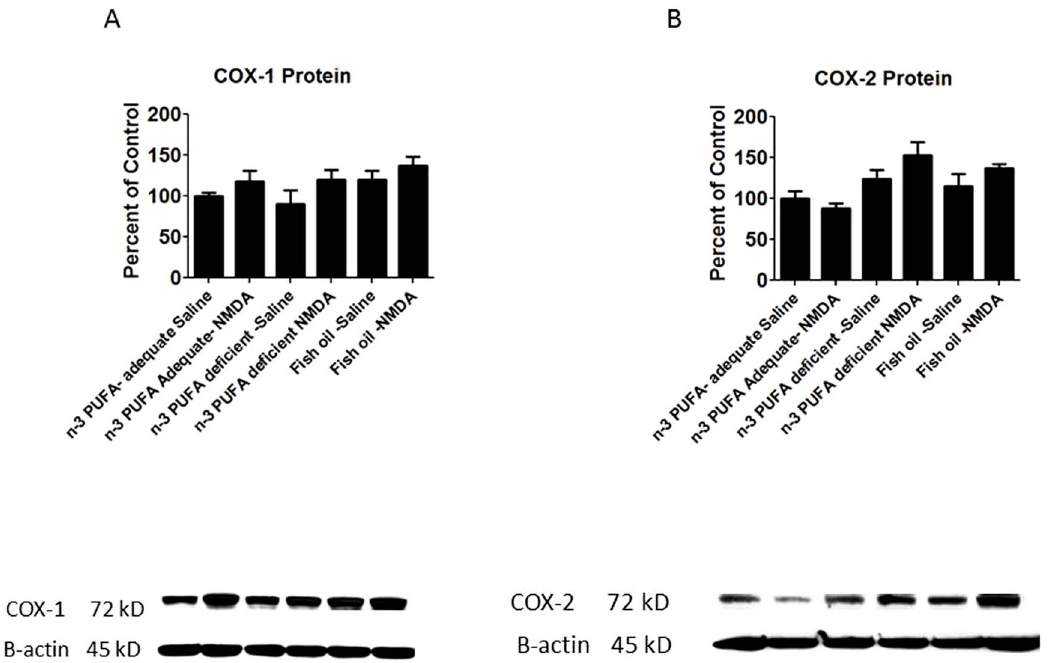
Figure 5. COX protein level. Measured protein levels of A) COX-1 and B) COX-2. Data are expressed as mean 6 SEM (n=5 per group for protein due to one unquantifiable band per group). Statistical significance is denoted by * p # 0.05, ** p , 0.01, *** p ,